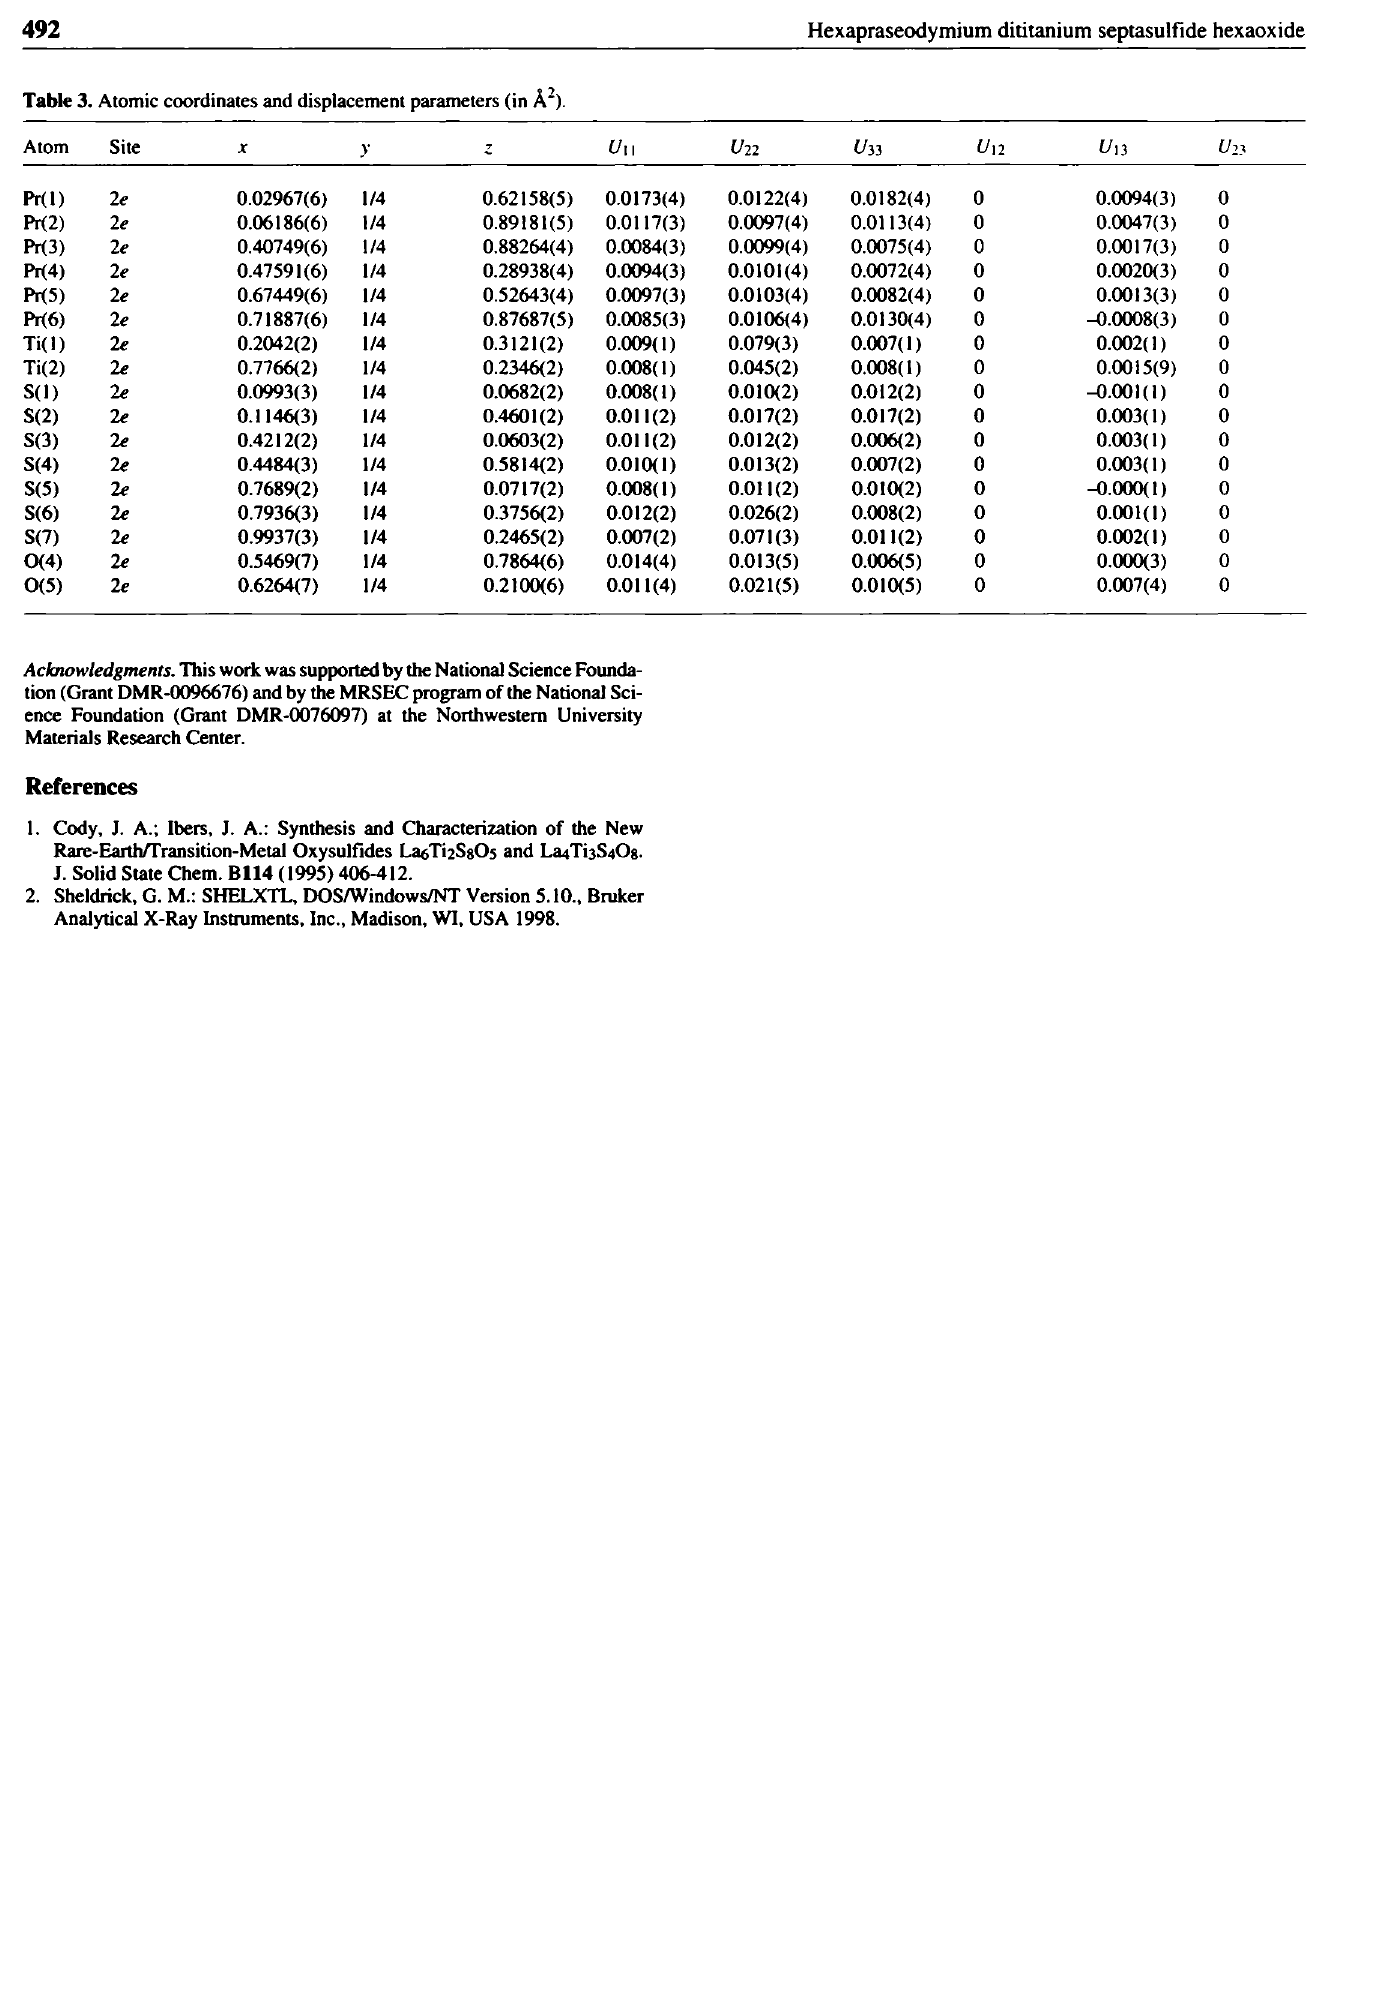
Table 3. Atomic coordinates and displacement parameters (in Ä 2